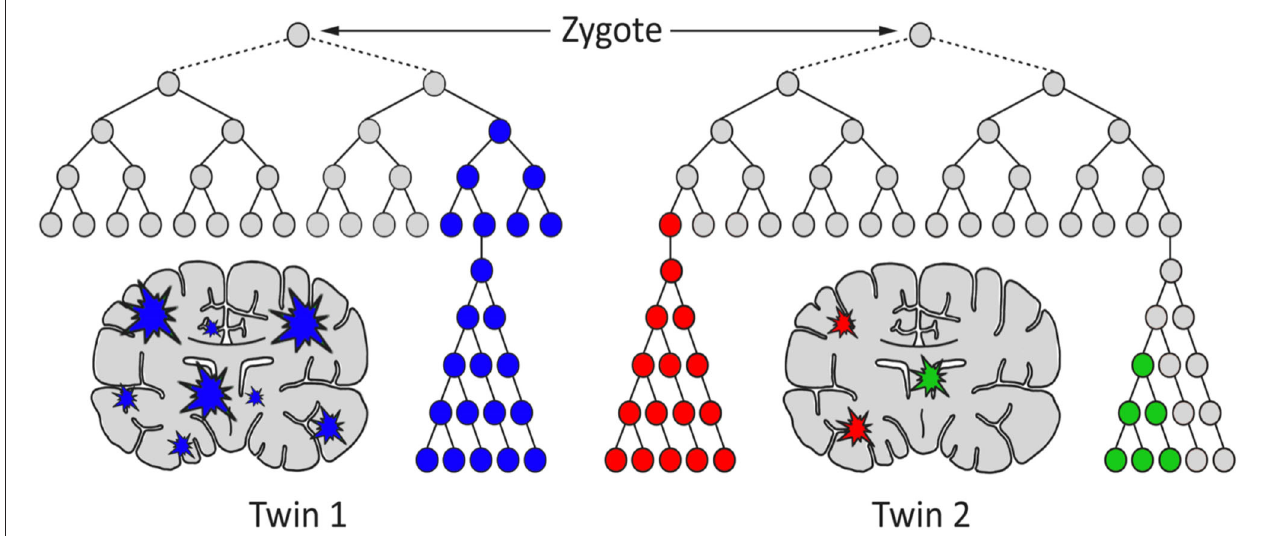
FIGURE 1 | A hypothetical model for the generation of genetic differences between brains of monozygotic twins by postzygotic mutations (PZM). The timing, genes affected, clonality, and brain region(s) affected may cause the twins to develop discordance for neurodevelopmental diseases, including